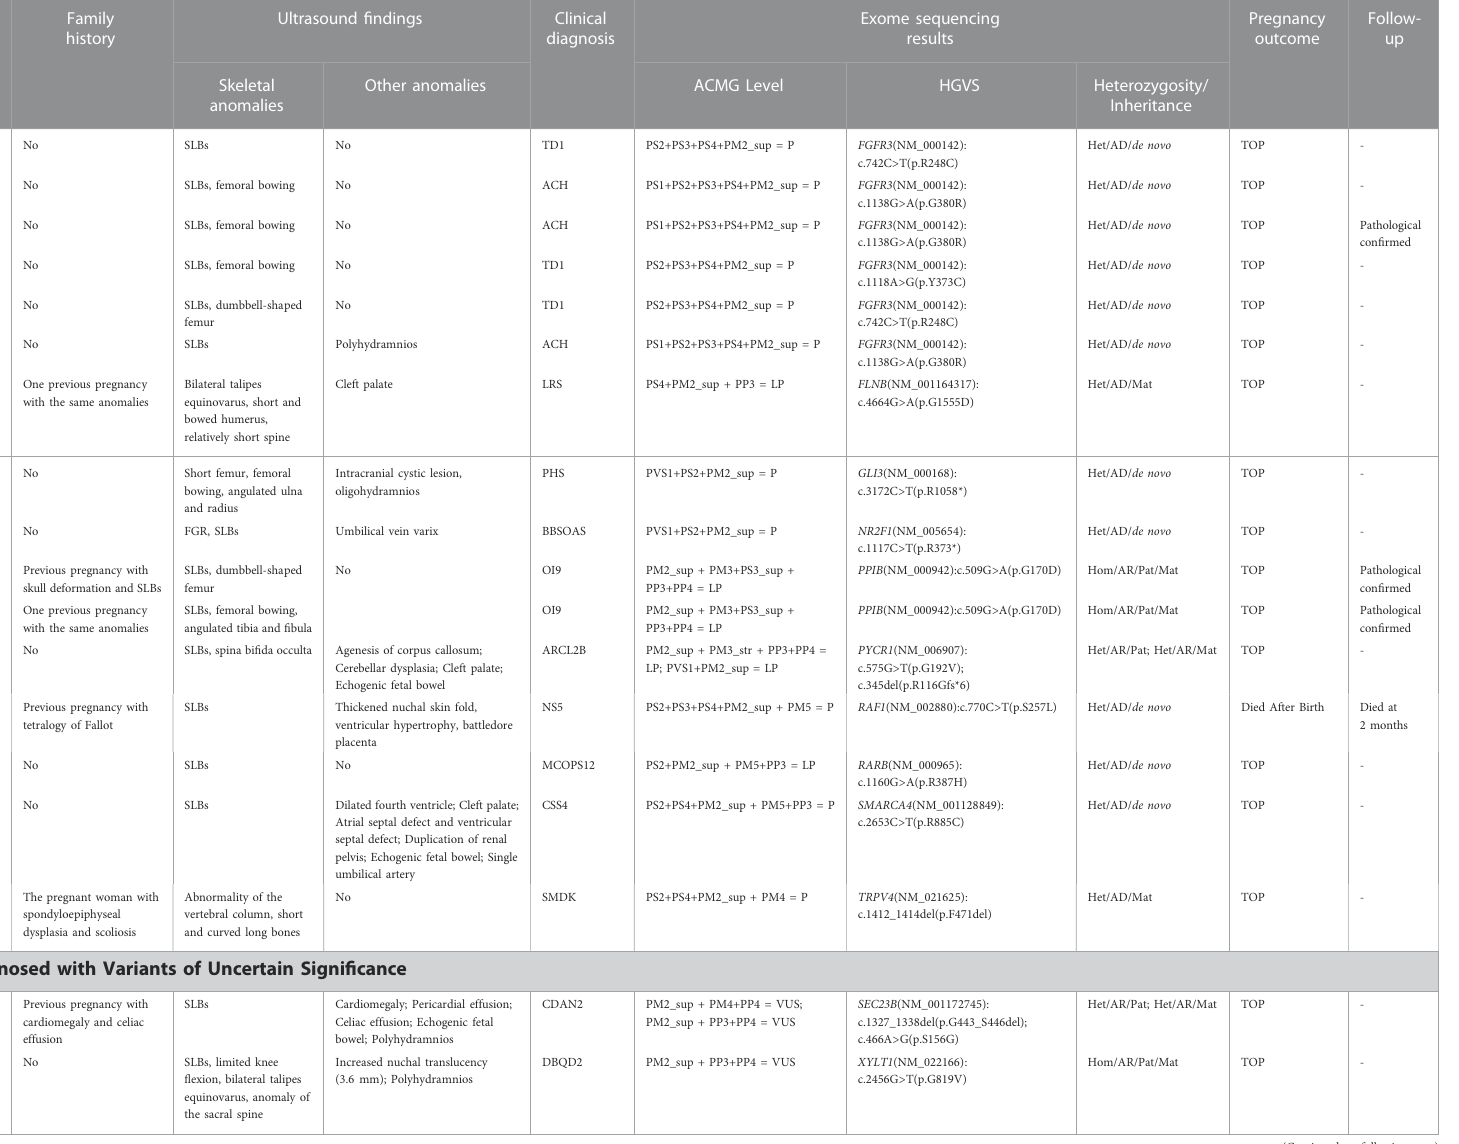
(B) Patients Suspiciously Diagnosed with Variants of Uncertain Signi fi cance